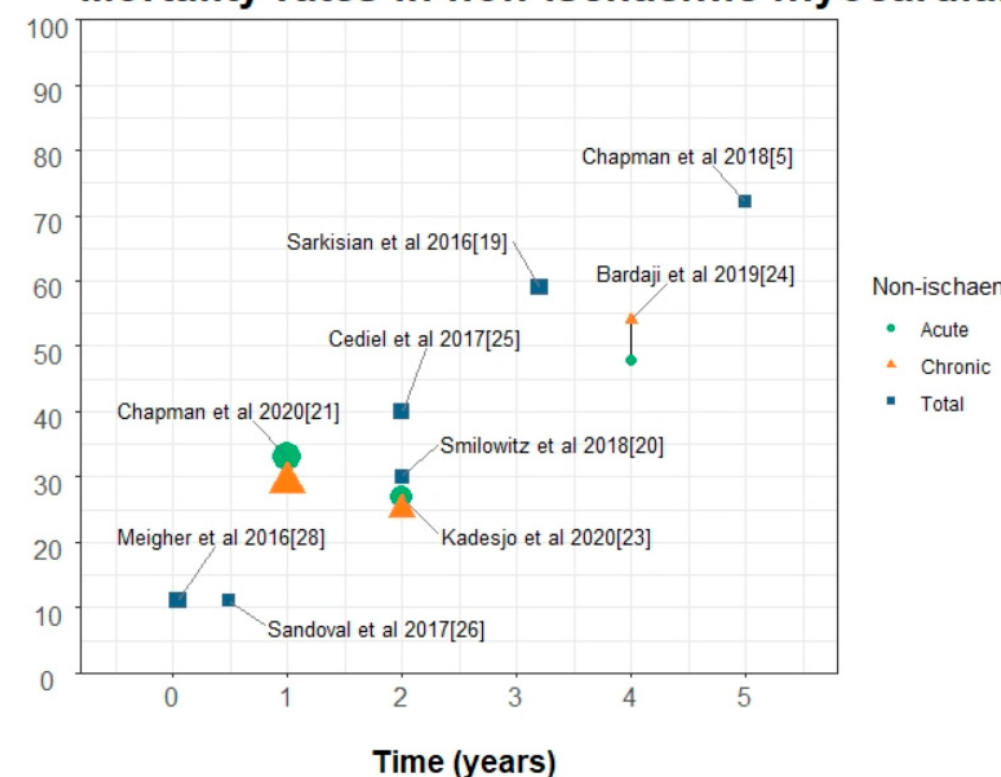
Figure 4. Mortality rates of non-ischaemic myocardial injury stratified into acute and chronic in studies from 2016 to 2020; titles are main study author and year as described in Table 1. Studies conducted before the 4th universal definition are displayed as total non-ischaemic myocardial injury, shape size is proportional to the number of study participants.